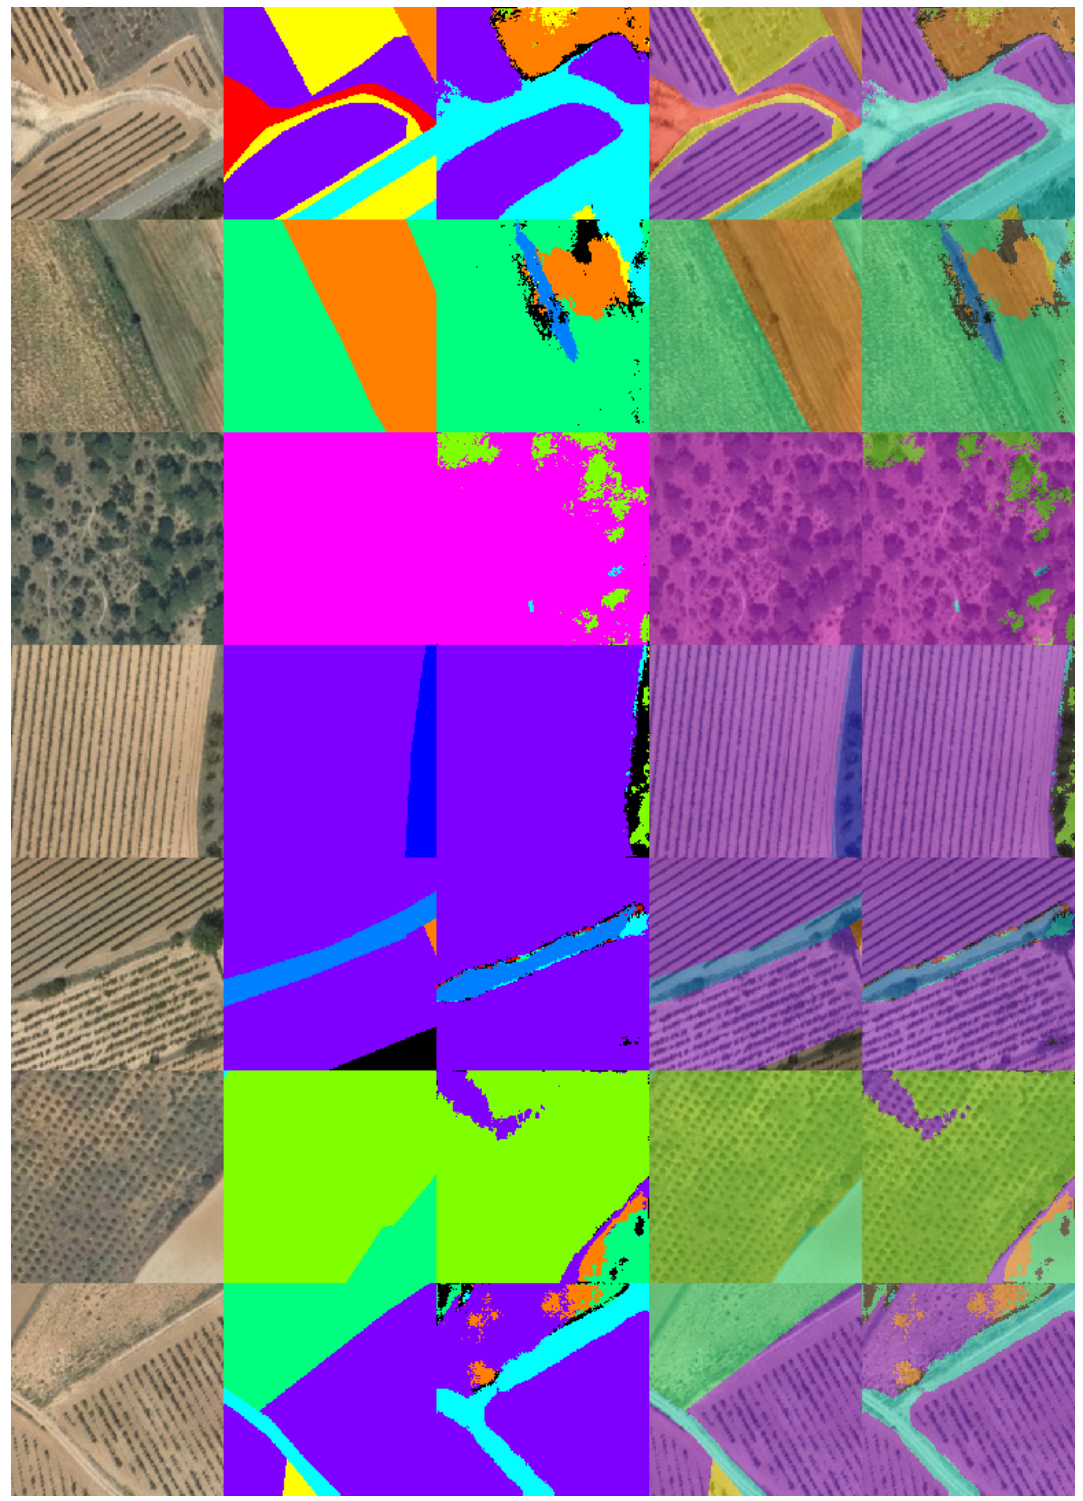
Figure 12. Visualization of the predicted results for UNet evaluated in UOPNOA with “Other” class (Experiment All- Purpose). ( 1st col. ) Original images, ( 2nd col. ) ground truth masks, ( 3rd col. ) predictions, ( 4th col. ) overlapping of original images with ground truth masks, ( 5th col. ) overlapping of original images with